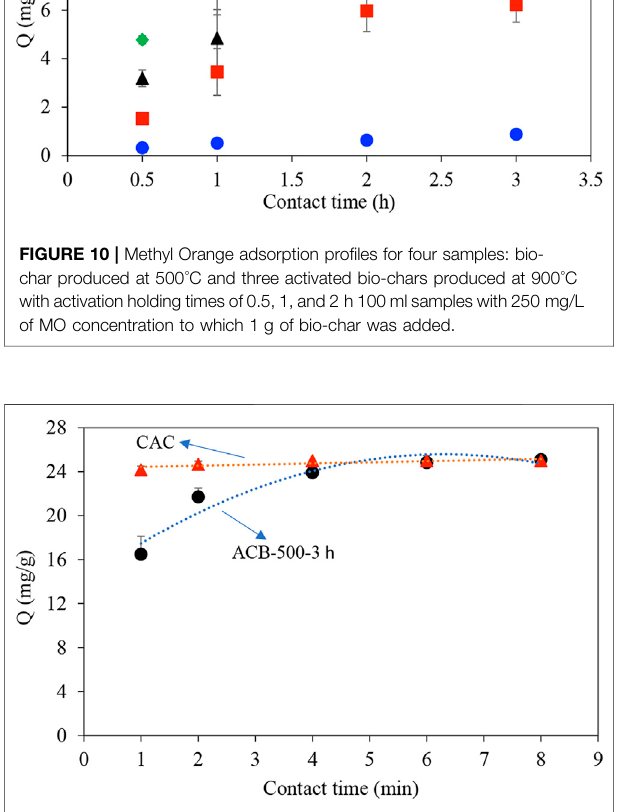
FIGURE 11 | Comparison of MO adsorption pro fi le using ACB-500-3 h sample and commercial activated carbon (CAC). 100 ml samples with 250 mg/L ofMOconcentration towhich 1 gofbio-char and CAC wasadded, trendlines are added for a better illustration.